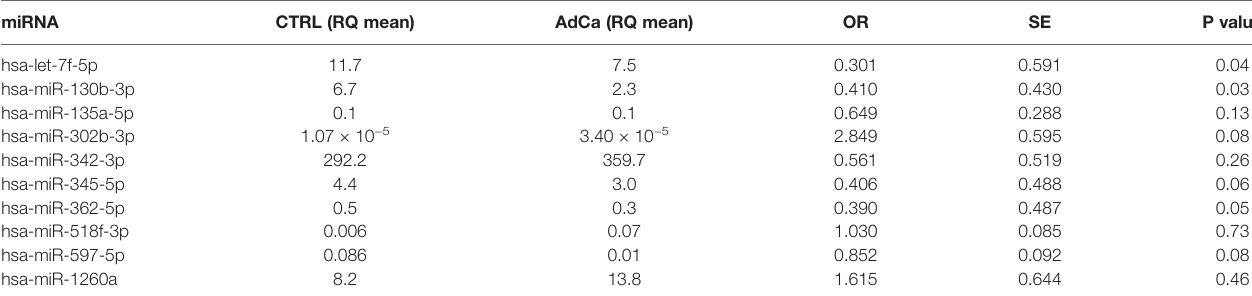
TABLE 2 | Validation analysis: the expression level and odds ratio (OR) of the plasmatic miRNAs is reported 3 . miRNA CTRL (RQ mean) AdCa (RQ mean) OR SE P